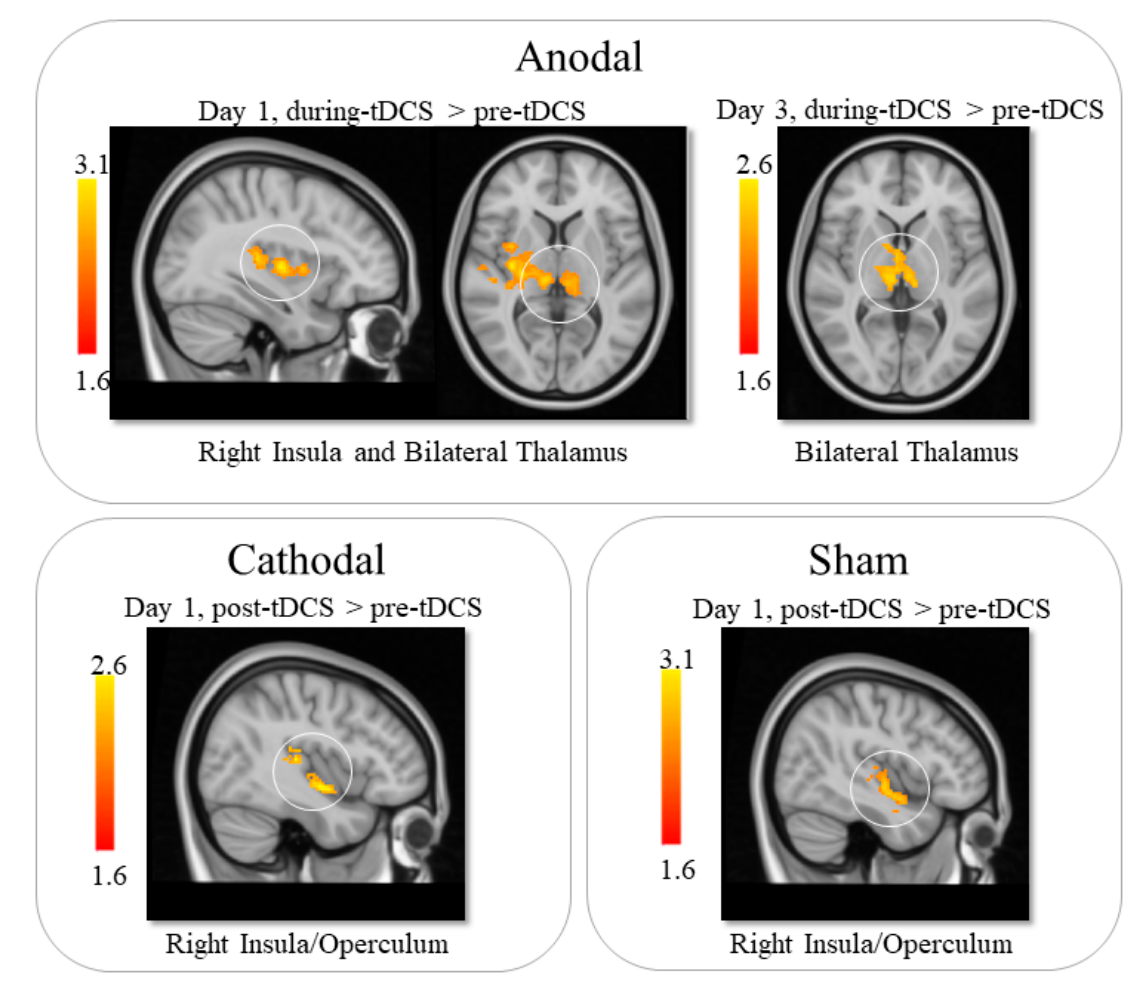
Figure 2. ASL statistical analysis results. Anodal tDCS led to increased CBF in the bilateral thalamus and insula during stimulation on day 1. While on day 3, anodal tDCS was associated with increased CBF in the bilateral thalamus during stimulation. Cathodal and sham tDCS led to increased CBF in the right insula after stimulation on day 1.